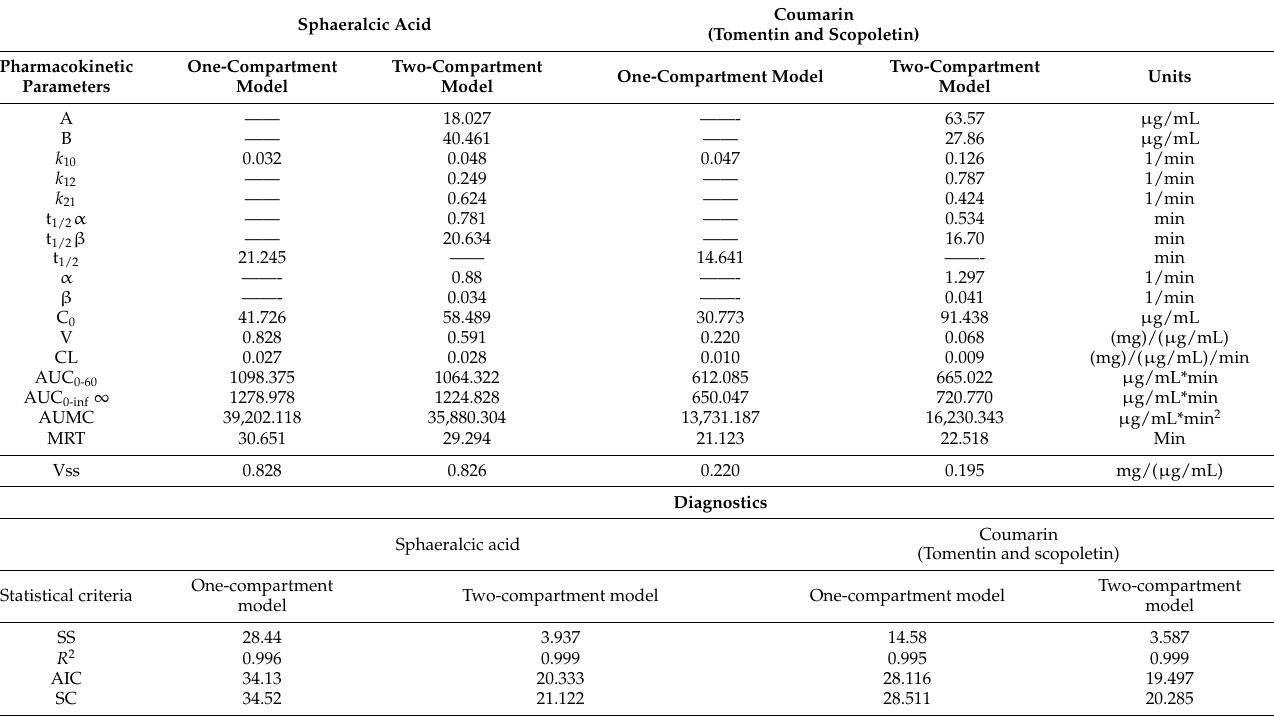
Table 5. Pharmacokinetic parameters after intravenous administration of the coumarin (tomentin and scopoletin) and sphaeralcic acid present in the SaTES standardized fraction (400 mg/kg) of Sphaeralcea angustifolia in the plasma of ICR mice; n = 3. The analysis fit into the one and two compartment